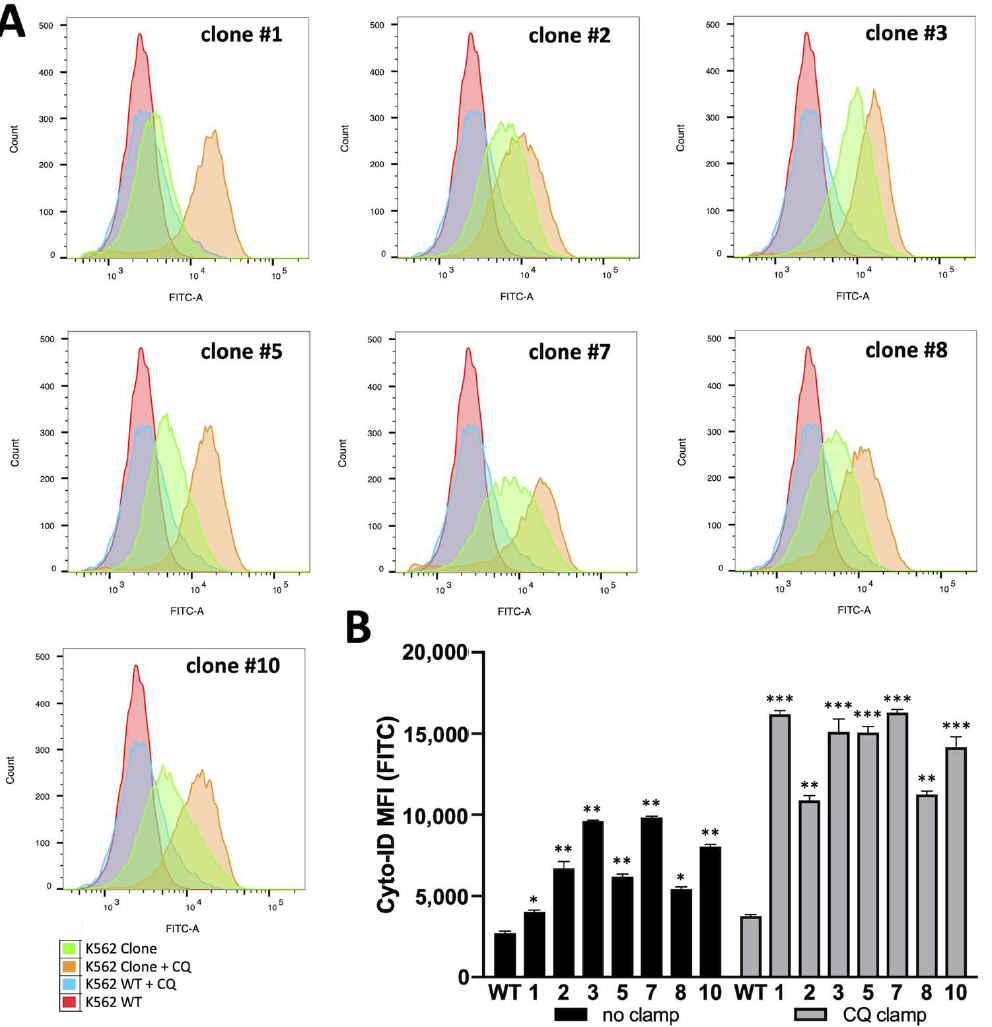
Figure 4. α -globin hyper-expression inducing autophagy in K562 cells, K562 wild-type cells (red curve) and tested clones (green curves) were clamped with chloroquine 40 µ M for 48 h (blue and orange curves, respectively) to provide a clear shift in autophagy signal (Cyto-ID) ( A ). Autophagy levels in K562 cells and obtained clones hyper-expressing α -globin (mean ± SD; N = 3); basal autophagy levels are increased in clones (black histograms) and further increase blocking autophagosome degradation with chloroquine (grey histograms) ( B ). p < 0.05 (*), p < 0.01 (**), p < 0.001 (***).